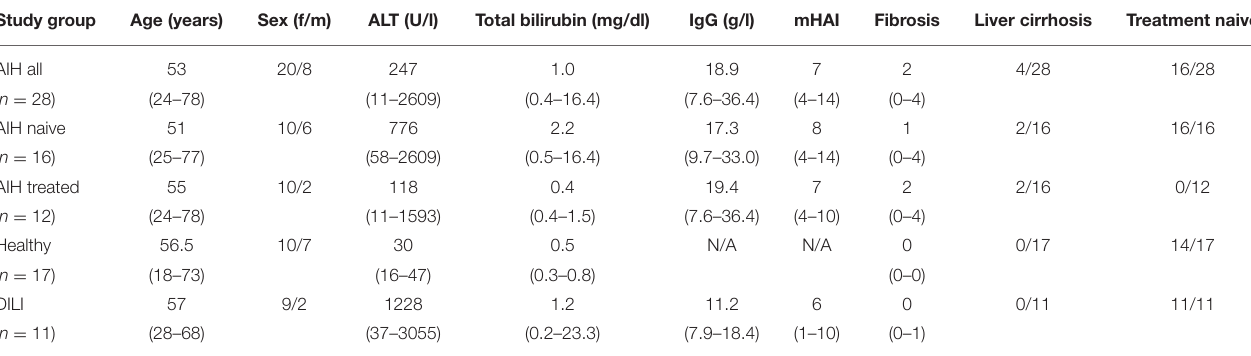
TABLE 2 | Clinical characteristics of AIH patients and control groups at the time of analyses of intrahepatic unconventional T cells (at the time of liver biopsies). Study